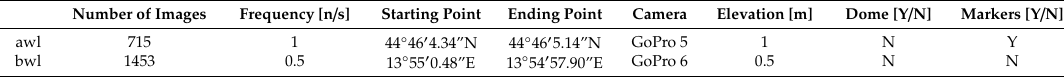
Table 3. Acquisition parameters of the plunging cli ff s at Premantura